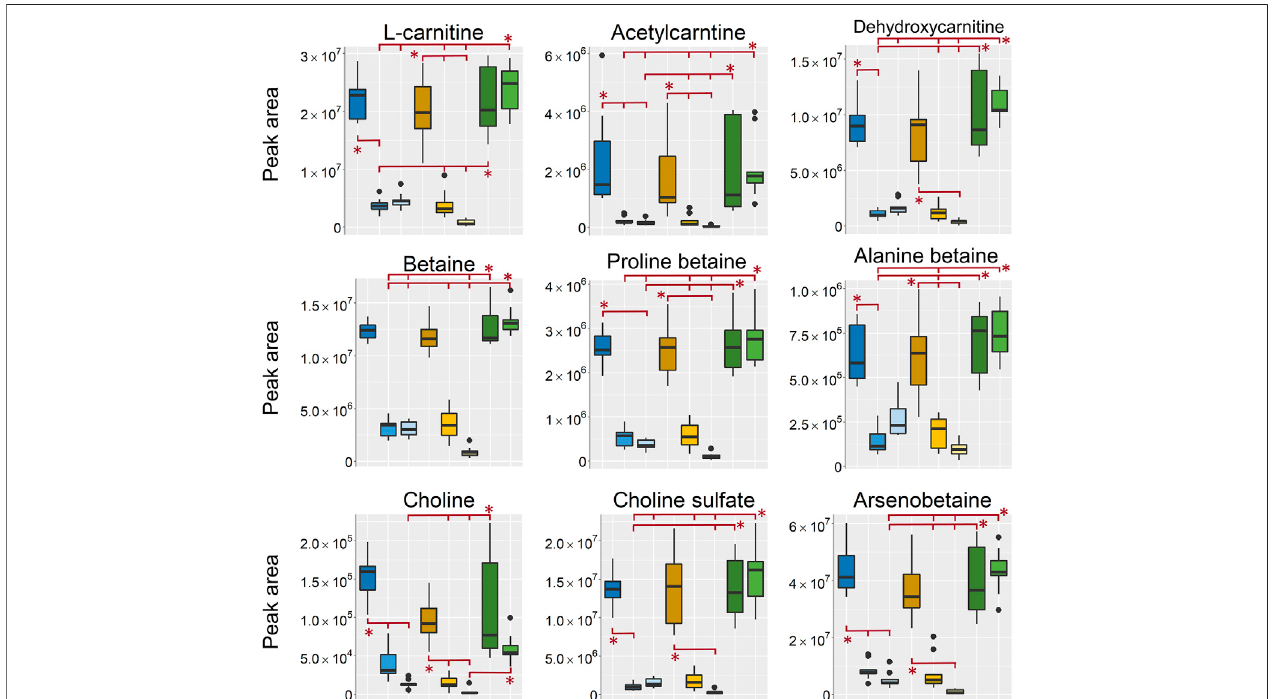
FIGURE 8 | Boxplots of peak areas (y-axis) of betaines, carnitines and other osmolytes found as differentiating between the sample treatments. All boxplots in the fi gure was based on data from the analysis in positive ionization mode. EtOH extr.1 (dark blue ), EtOH extr.2 (blue ), EtOH sp. (light blue ), MeOH extr.1 (dark orange ), MeOH extr.2 (yellow ), MeOH sp. (light yellow ), frozen (dark green ) and fl ash frozen (green ). Outliers are denoted as dots in the plots. Statistical signi fi cance (p < 0.05) ismarked by* in therespective box-plots, all p-values from the Kruskal Wallis and Nemenyi post-hoc testing canbe found insupplementary data, Supplementary Table S11 .